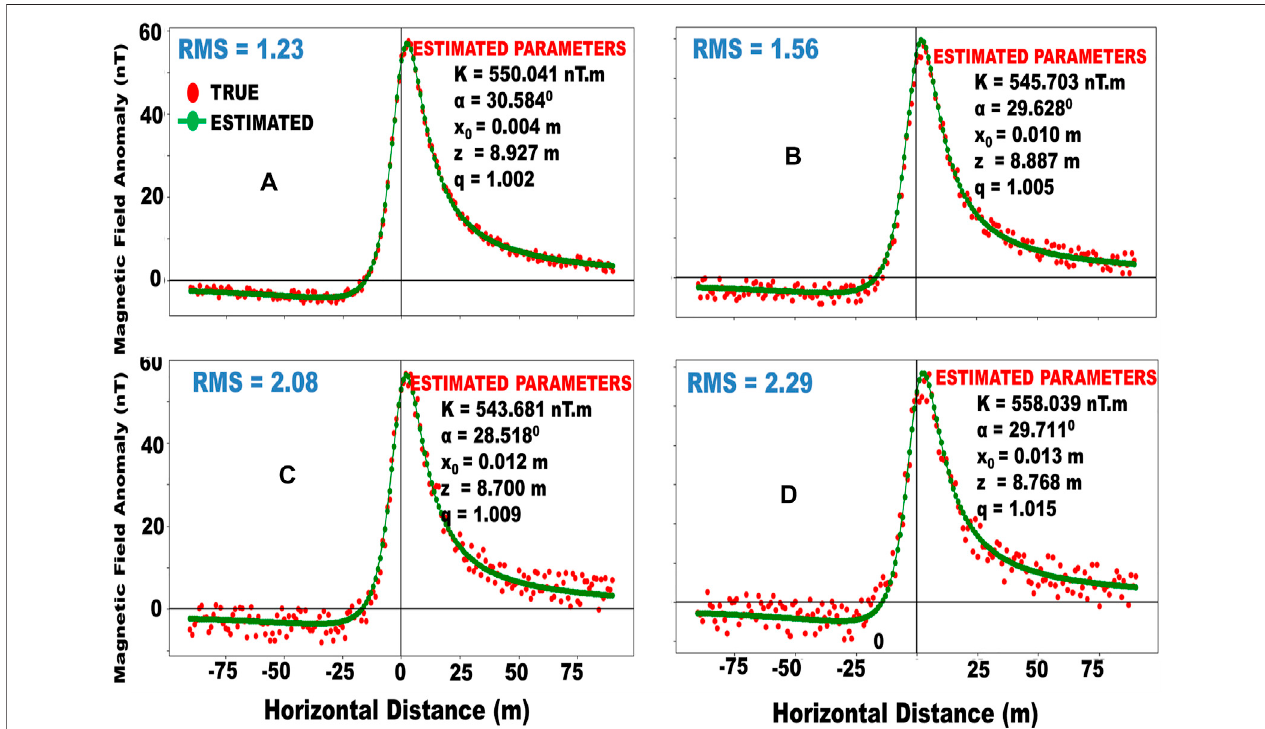
FIGURE6| Syntheticallygeneratednoisyandestimated(MFR)magneticanomaliesforathinsheetmodelwithK=550 nT m,z=9 m, α =30,q=1,xo=0 m,with (A) 5% (B) 10% (C) 15% (D) 20% gaussian random error.